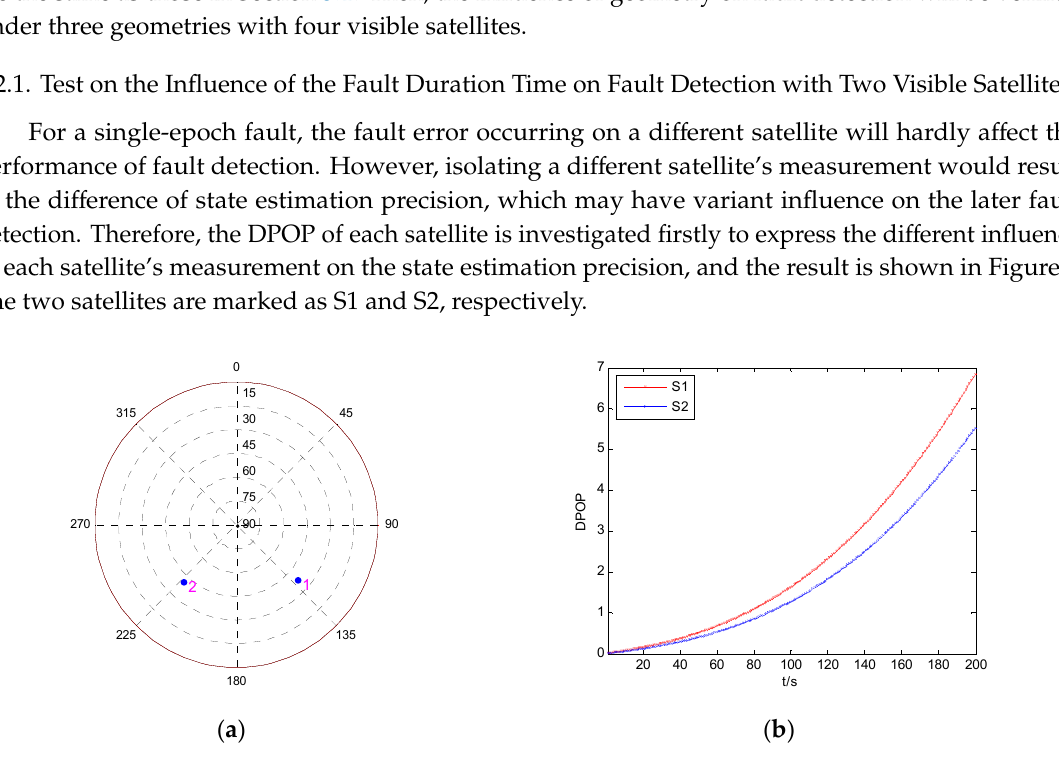
Figure 7. The geometry and DPOP of two visible satellites. ( a ) Sky plot view of the satellite geometry; ( b ) DPOP of each satellite as function of time.